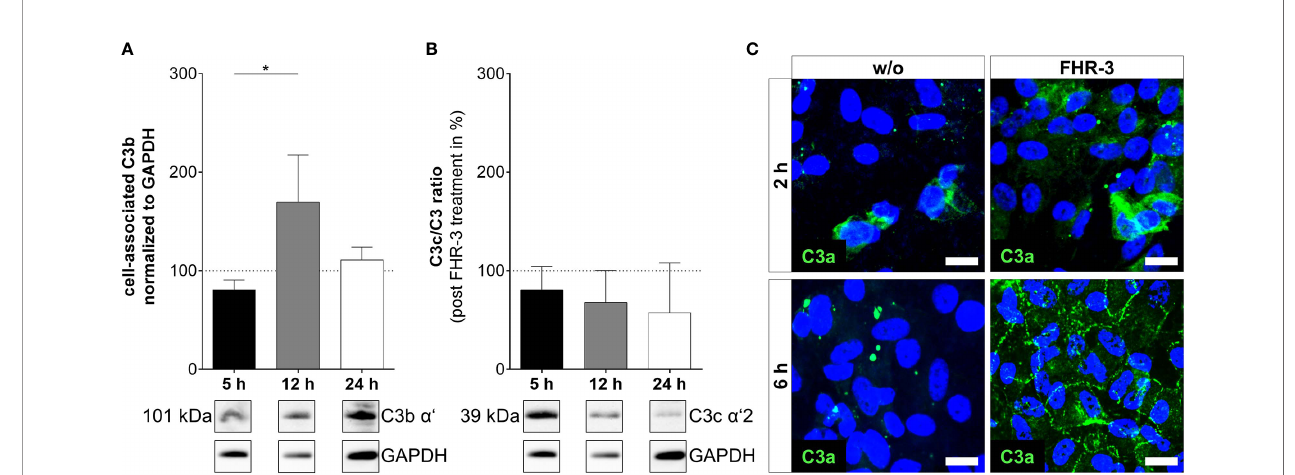
FIGURE 4 | C3 cleavage products were changed in ARPE-19 cells after FHR-3 incubation. (A) Increased C3b levels (101 kDa) 12 h after FHR-3 treatment and (B) a time-dependent reduction of C3c fragments (39 kDa) in ratio to pro-C3 were detected in Western blots of ARPE-19 cell lysates. Supplementary Figure 1K shows full Western blots. (C) Anaphylatoxin C3a was detected by immuno fl uorescence using a speci fi c anti-C3a antibody (green). C3a increased time-dependently from 2 h to 6 h after FHR-3 treatment and was translocated from the cytoplasm (upper right panel) to the cell membrane (lower right panel). Scale bars 40 µm. w/o untreated control (dotted line). Mean with standard deviation is shown. *p < 0.05. (A, B) Ordinary one-way ANOVA, Turkey ’ s multiple comparisons test (n = 3).